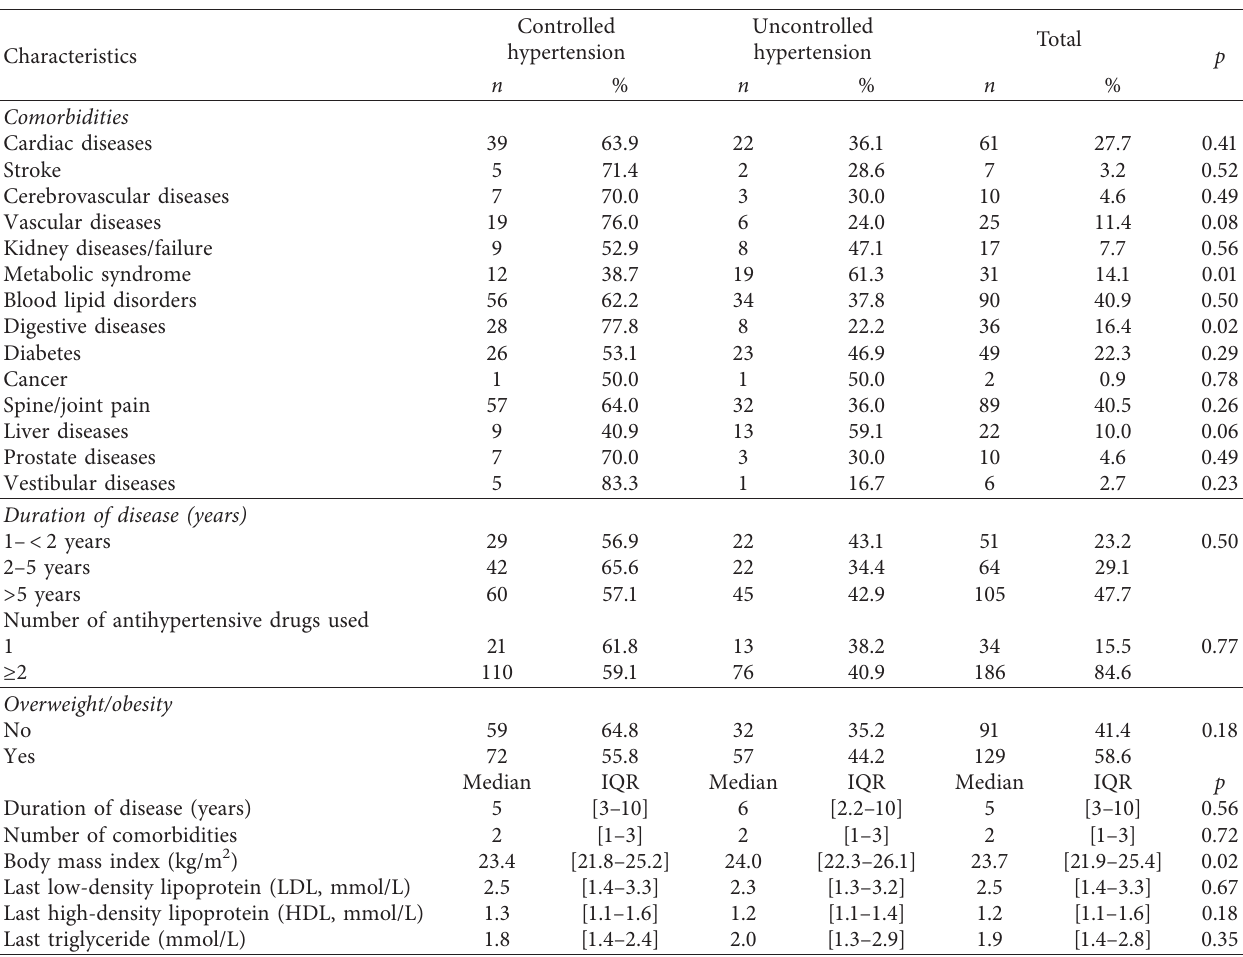
Table 2: Clinical characteristics of hypertensive